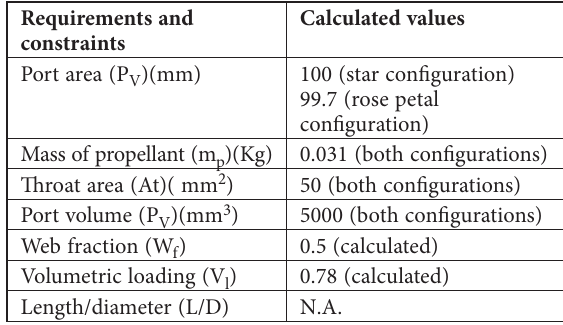
Fig. 11. Rose petal grain thrust and burn area time curves